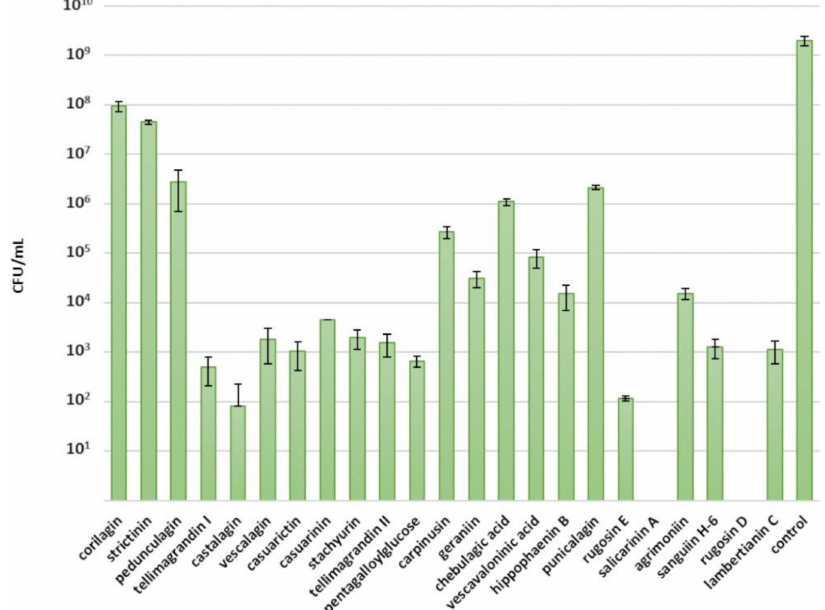
Figure 3. Growth of Staphylococcus aureus following a 24 h treatment with 0.5 mM ellagitannin and pentagalloylglucose solutions. Growth is expressed as number of colony-forming units (CFU) per mL (CFU / mL, mean values and standard deviations, n = 3). All 23 tested tannins are in the order of increasing molecular weight (CFU / mL in base 10 logarithmic scale); p < 0.05 for all